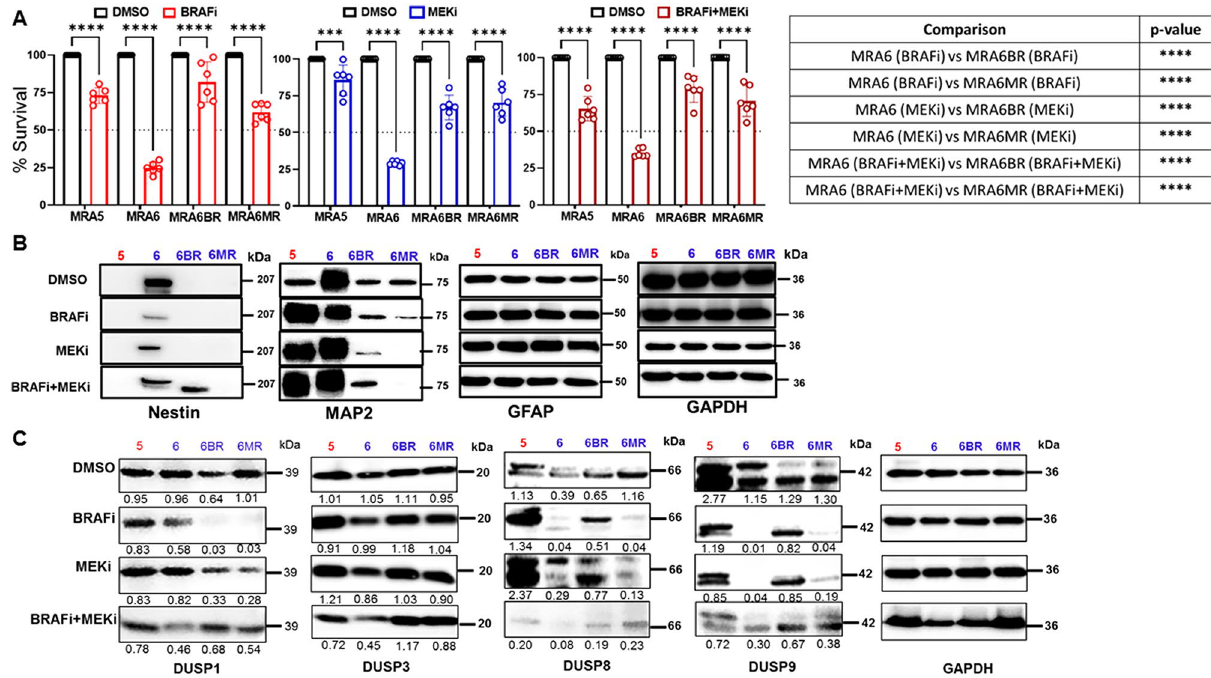
Figure 2. Expression of neural markers and DUSPs in MAPKi-sensitive and -resistant metastatic melanoma cells. ( A ) Effect of BRAFi (PLX4032), MEKi (AZD6244) alone or combination of BRAFi + MEKi on survival of intrinsically MAPKi-resistant MRA5, MAPKi-sensitive MRA6 cell lines and BRAFi-resistant MRA6BR and MEKi-resistant MRA6MR metastatic melanoma cells. Cells were plated in 6 replicates in 96-well plate and treated with DMSO or 10 μM BRAFi PLX4032 or MEKi AZD6244 or combination of 5 µM BRAFi and 5 µM MEKi for 72 h. Data shown as mean ± SD were analyzed by Student’s t-test. *Indicates P ≤ 0.05; * * < 0.01; * * * < 0.001; * * ** < 0.0001. ( B ) Western blot analysis showing the expression of neural stem cell marker Nestin, and neural differentiation markers MAP2 and GFAP proteins after 48 h treatment with DMSO or 10 μM BRAFi or MEKi or combination of BRAFi and MEKi. GAPDH levels were used to monitor protein loading. Numbers on the right indicate the molecular (kDa) of the respective proteins. Band intensities normalized to GAPDH expression using ImageJ are shown. ( C ) Western blot analysis showing expression of DUSP1, DUSP3, DUSP8 and DUSP9 proteins after 48 h treatment with DMSO or 10 μM BRAFi or MEKi or combination of BRAFi and MEKi. GAPDH levels were used to monitor protein loading. Numbers on the right indicate the molecular (kDa) of the respective proteins. Band intensities normalized to GAPDH expression using ImageJ are